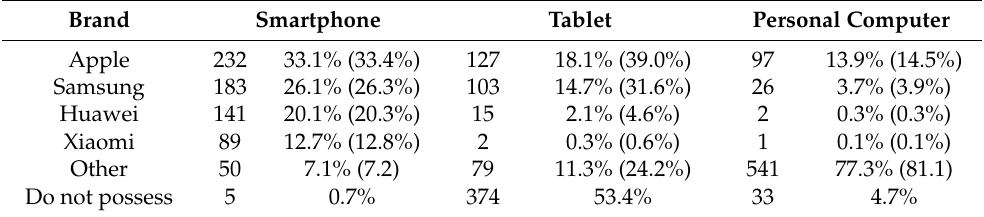
Table 2. Characterization of the brands owned by the respondents in what accounts for smartphone, tablet, and personal computers. The values between brackets were obtained considering only the ones who possess the type of product under evaluation. Brand